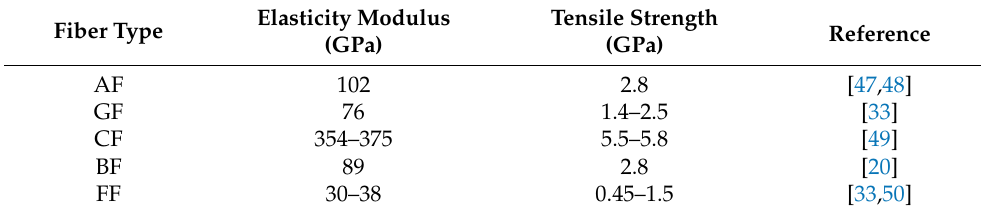
Table 1. Mechanical properties of the single fibers used in the